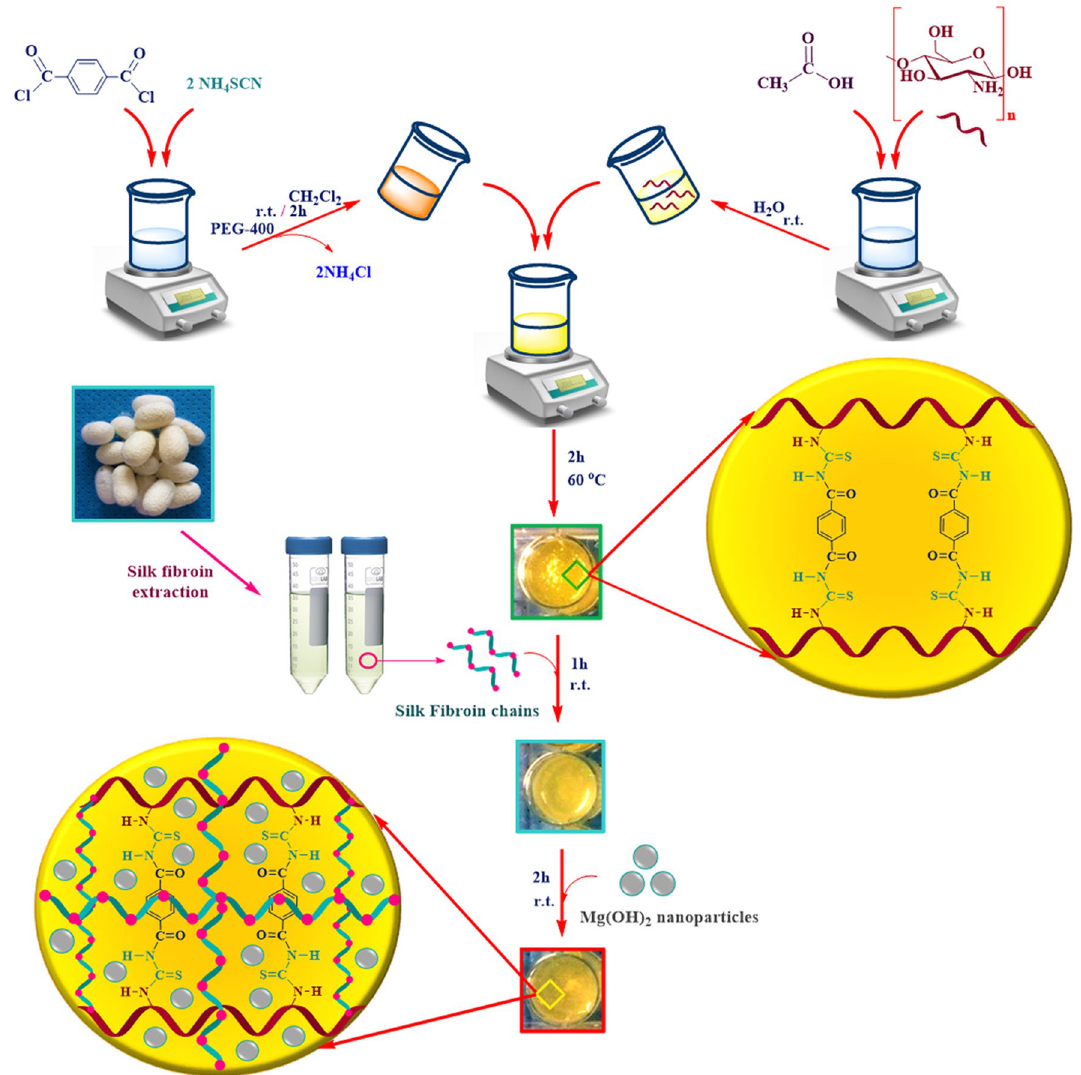
Figure 1. Synthesis preparation of CTT-CS/SF/Mg(OH) 2 nanobiocomposite